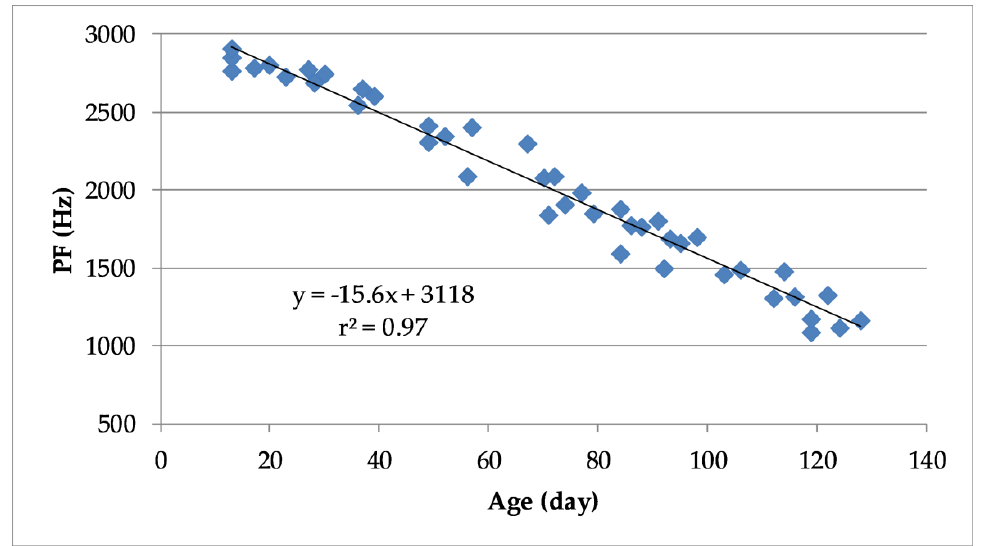
pooled data from all trials.